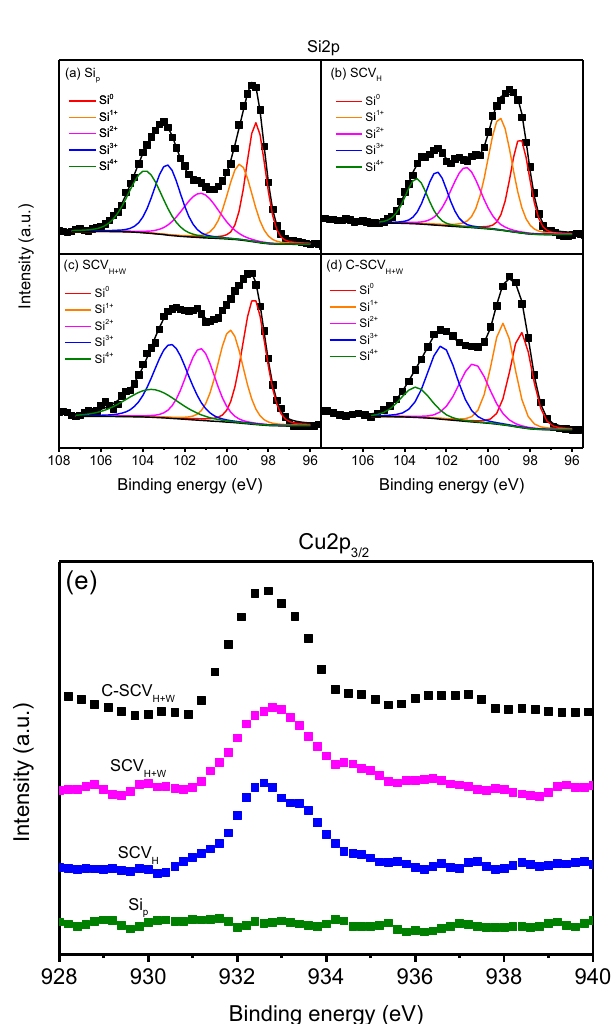
Figure 5. XPS spectra of the Si2p for ( a ) Si P , ( b ) SCV H , ( c ) SCV H + W , ( d ) C-SCV H + W and ( e ) Cu2p 3/2 for Si P , SCV H , SCV H + W and C-SCV H + W , respectively.